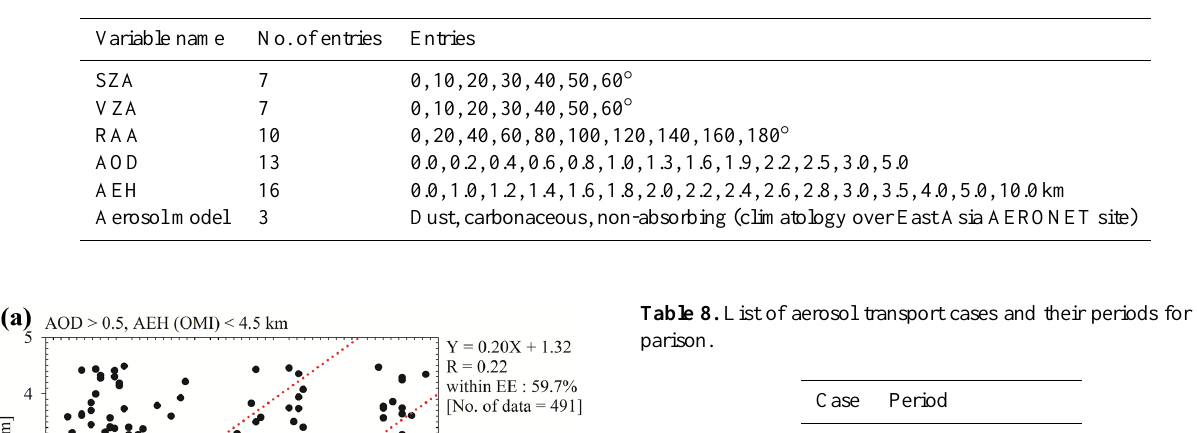
Table 7. Dimensions of LUT for the AEH algorithm using OMI.